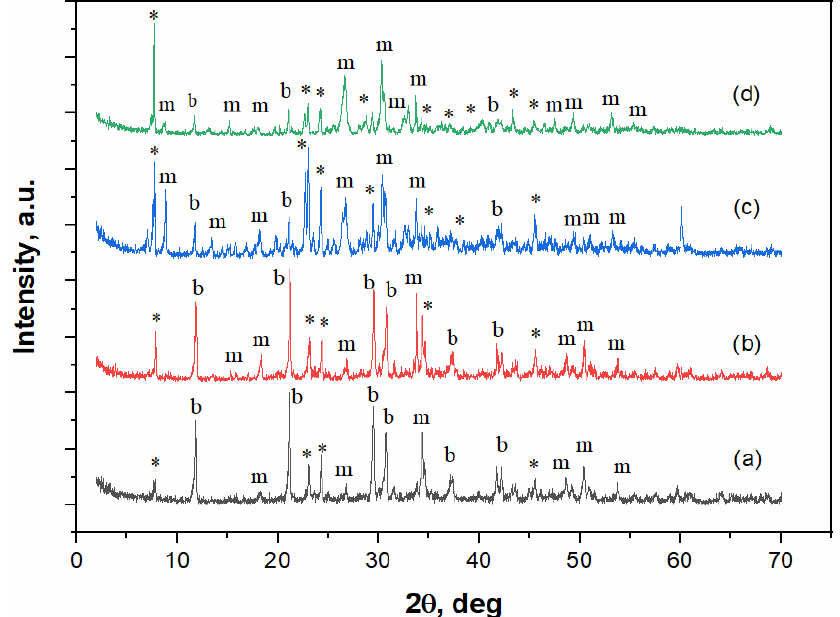
Figure 3. The XRD spectra of the cement-salt stone obtained from calcium citrate tetrahydrate and MCPM mixture with weight ratio of: ( a ) Ca(PO 3 ) 2 /Ca 2 P 2 O 7 = 0/100;.* – Ca(H 2 PO 4 ) 2 · H 2 O (PDF 9-347); b – CaHPO 4 · 2H 2 O (PDF 72-713); m – CaHPO 4 (PDF 75-1520). ( b ) Ca(PO 3 ) 2 /Ca 2 P 2 O 7 = 5/95, ( c ) Ca(PO 3 ) 2 /Ca 2 P 2 O 7 = 10/90, ( d ) Ca(PO 3 ) 2 /Ca 2 P 2 O 7 = 20/80. According to the XRD data, the phase composition of cement-salt stone with different ratios of MCPM to calcium citrate (Figure 3) is represented by brushite, monetite, and unreacted MCPM phases. Increasing the MCPM to calcium citrate molar ratio led to an